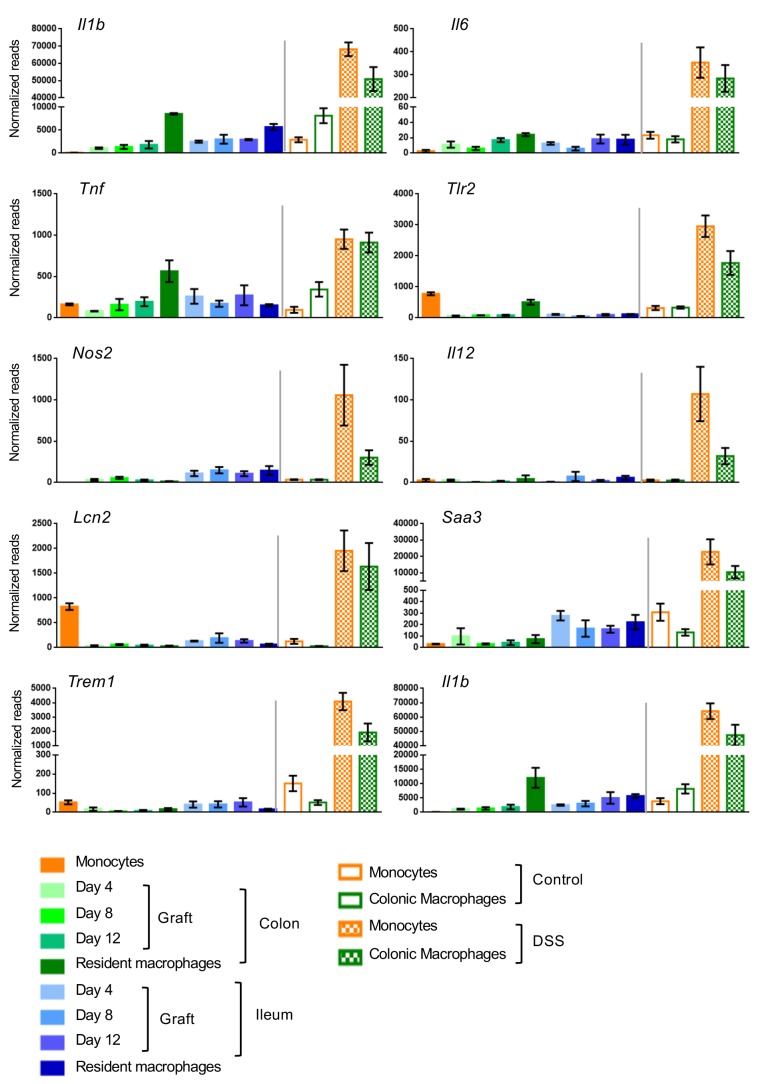
Analysis of expression of pro-inflammatory genes in adoptive transfer model and DSS-induced colitis model.Expression of genes in engrafted colonic and ileal macrophages, resident colonic and ileal macrophages at steady state, infiltrating monocytes and resident macrophages isolated from the colon of mice challenged with 1.5% DSS for 7 days and their respective controls.